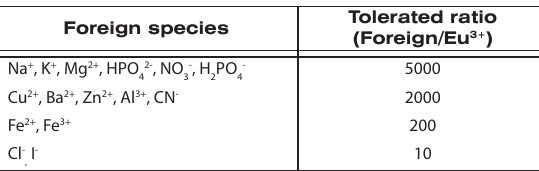
Table 3. The effect of other foreign species on the determination of Eu 3+ of 1.41×10 -8 mol L -1